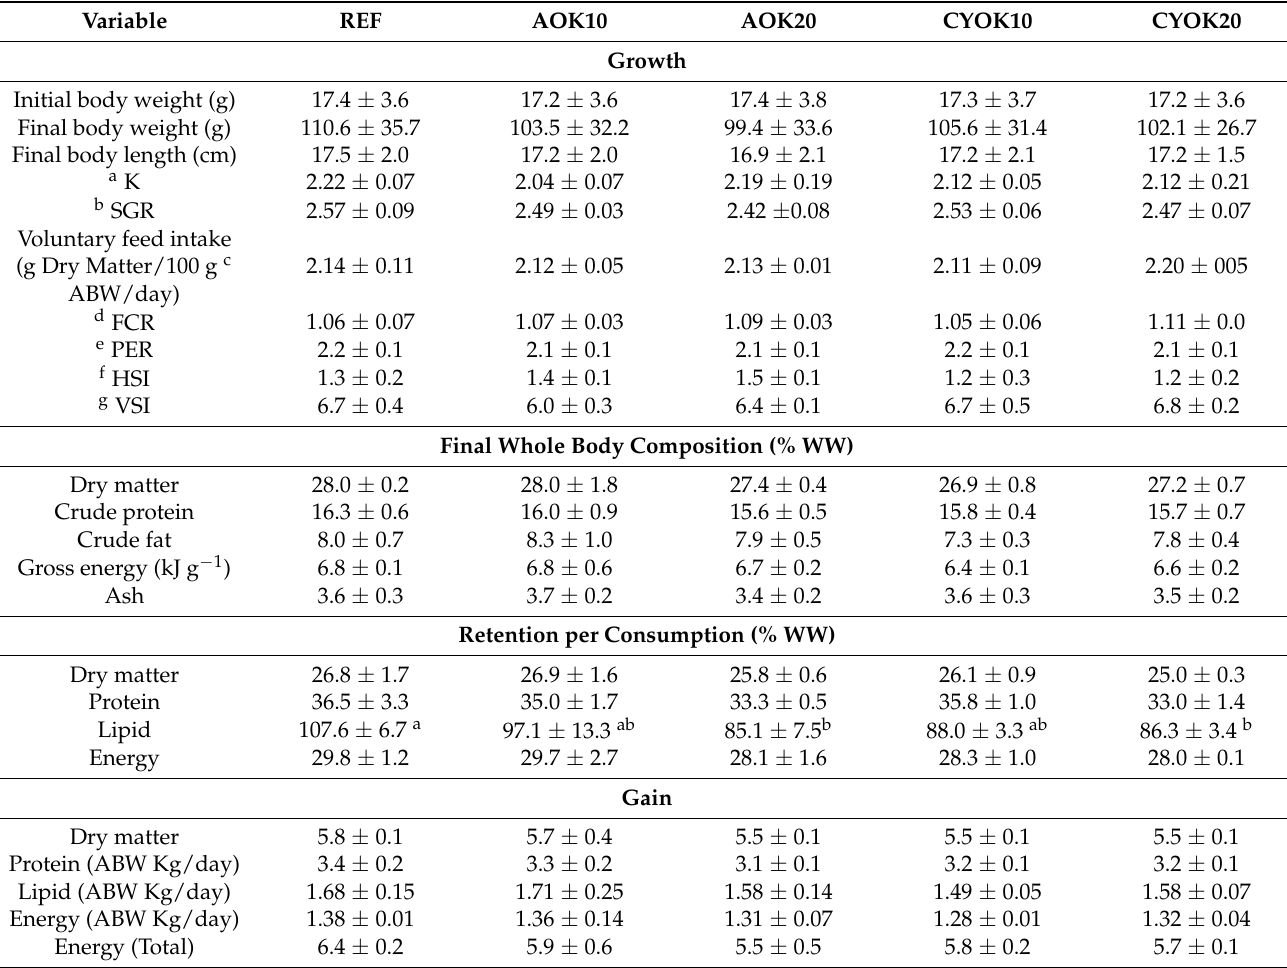
Table 6. Final growth performance, somatic indexes, and whole body composition (% or kJ g − 1 of wet weight (WW)) of Nile tilapia fed the experimental diets for 10